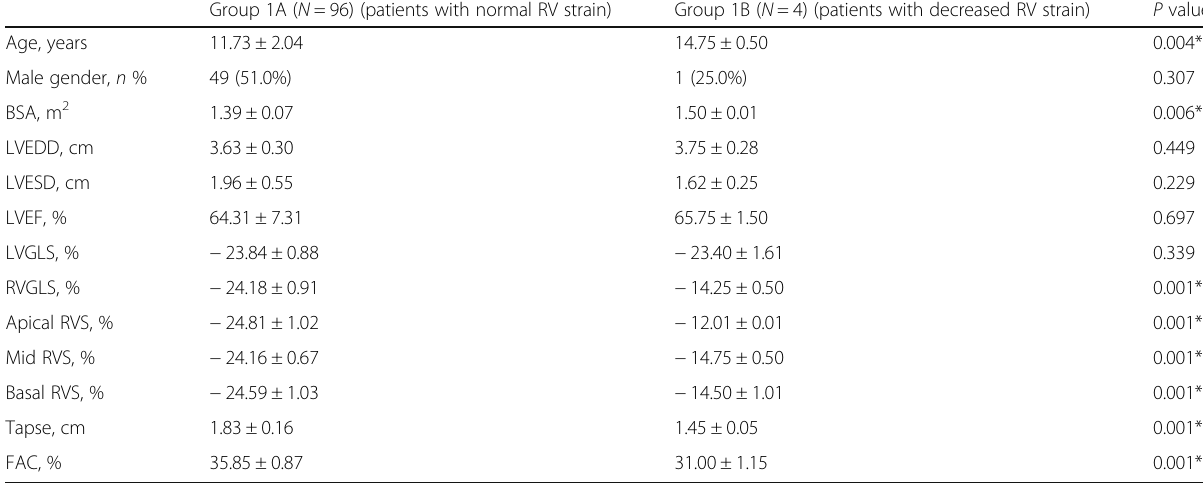
Table 6 Basal characteristics, echocardiographic results, and RV 2DSTE of group 1 subgroups after 3 months of follow-up after receiving chemotherapy Group 1A ( N = 96) (patients with normal RV strain) Group 1B ( N = 4) (patients with decreased RV